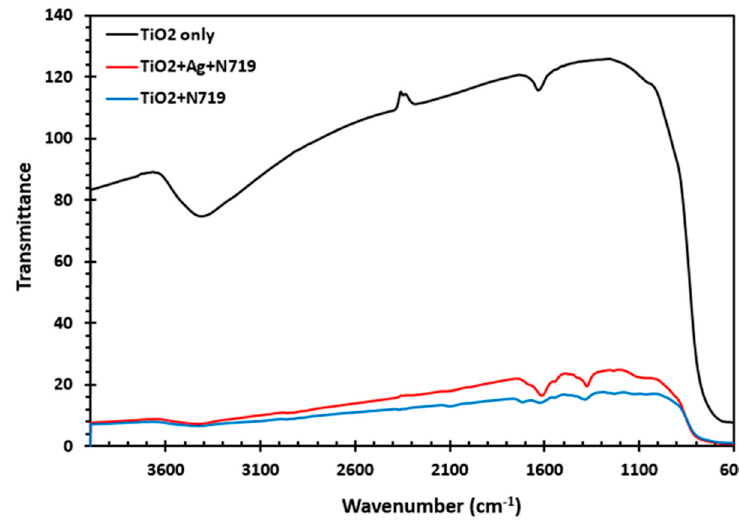
Figure 5. FTIR spectra of Silver Nanoparticles (AgNPs) infused titanium dioxide and bare titanium dioxide .